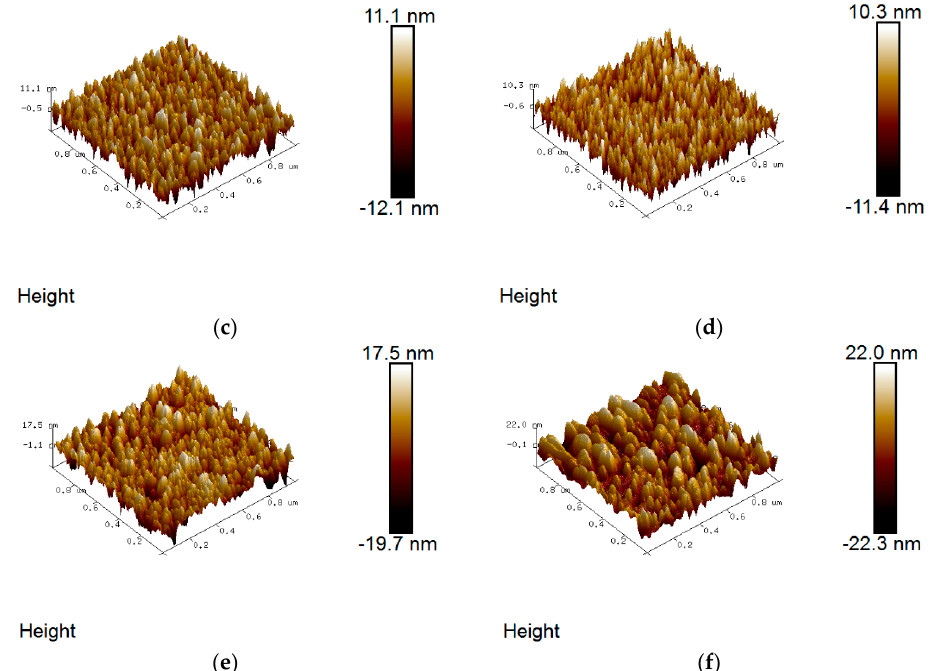
Figure 3. Atomic force microscopy (AFM) images of ZnO:Zr films grown on Si (100): ( a ) as-deposited;